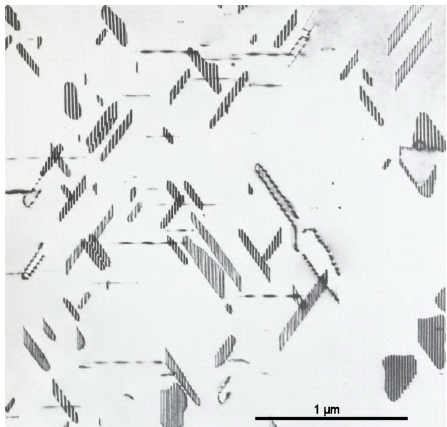
Figure 8. Image of type Ia diamond from work by Barry et al. showing large platelets. Reproduced with permission from [64]. Royal Society, 1987.